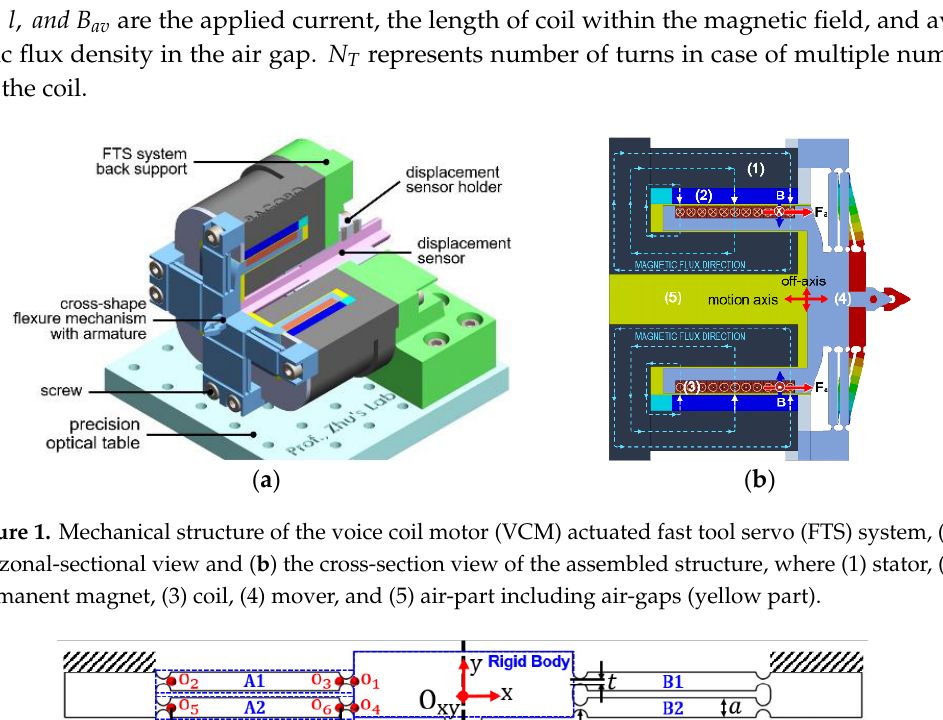
Table 1. Selected parameters for coil configuration, (copper wire (AWG23, 0.57mm diameter)). Symbol